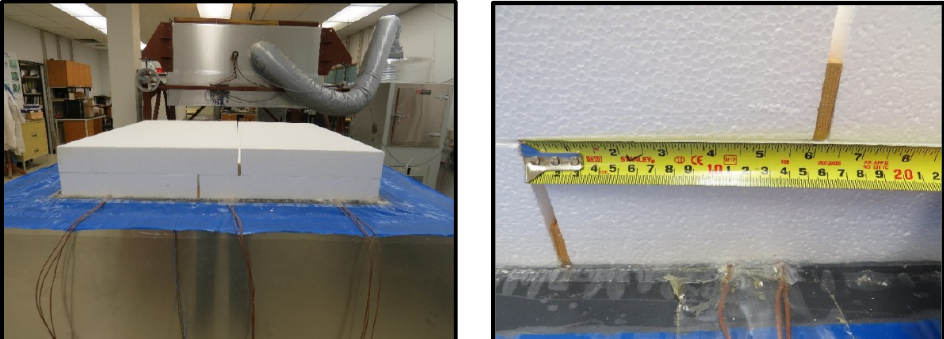
Figure 5. Photos of Staggered Gap Configuration.